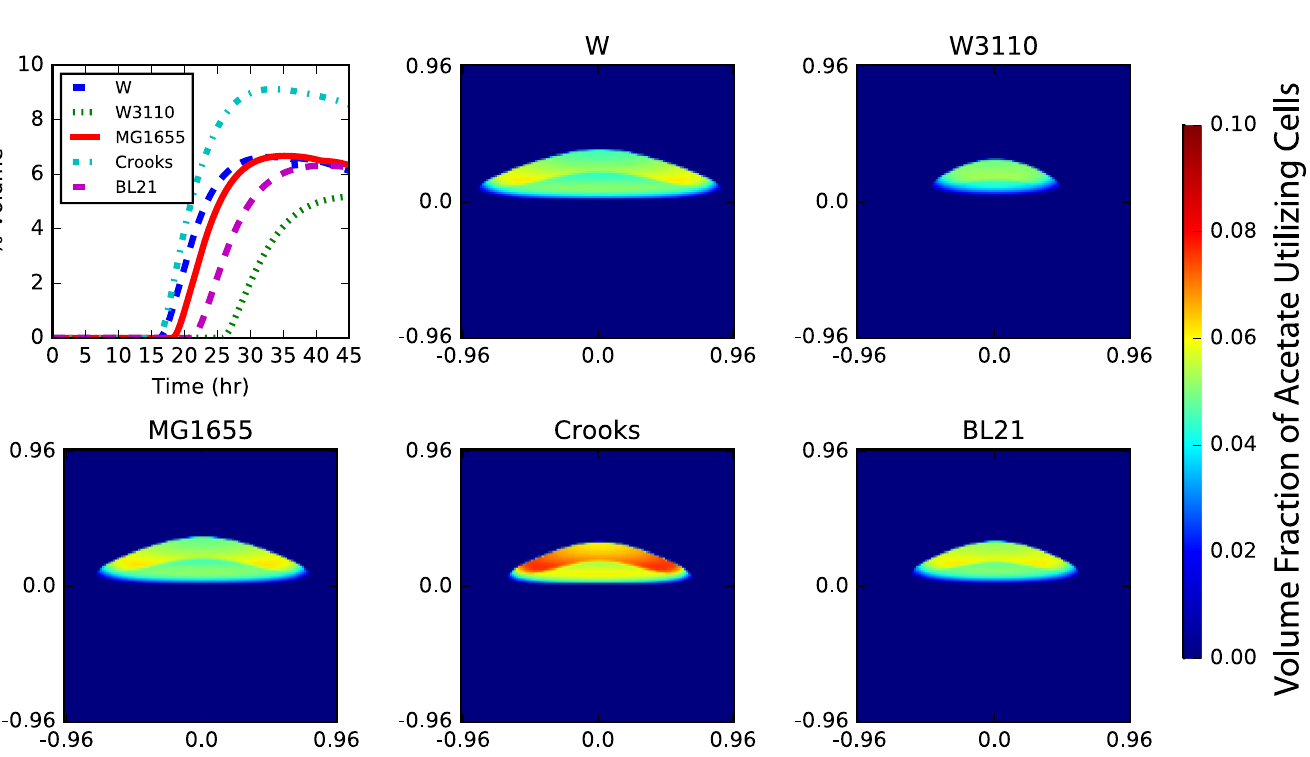
Fig 5. Strain dependence of crossfeeding. Differencesin metaboliteutilization efficiency of closely related E. coli strains give rise to differences in metaboliccross-feeding. Cross-sections of the acetate utilizingvolume fraction of cells after 30 hours of growth show that, whilethe colony growth rates are slightly different, the structure of the metaboliccross-feeding is essentiallythe same (heatmaps). A quantification of colony volume, however,shows that the fraction of colony that utilize acetate can vary by a factor of 2 and the timing for onset of metaboliccooperativity can vary by up to 10 hours (top left). The acetate utilizingfraction are cells that have transitionedinto the phenotypicstate where they can catabolizeacetate; while these cells are not necessarily consumingacetate, they have the capacity to do so. In general,about 70% of these cells are consumingacetate and are doing so at the maximum uptake